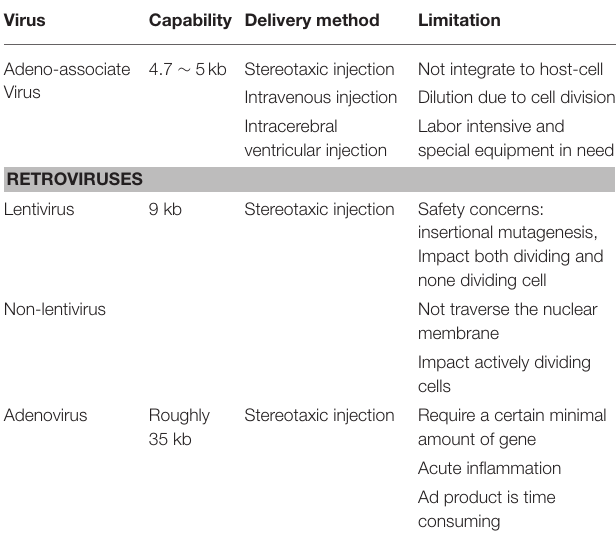
TABLE 1A | Virus vector mediates gene